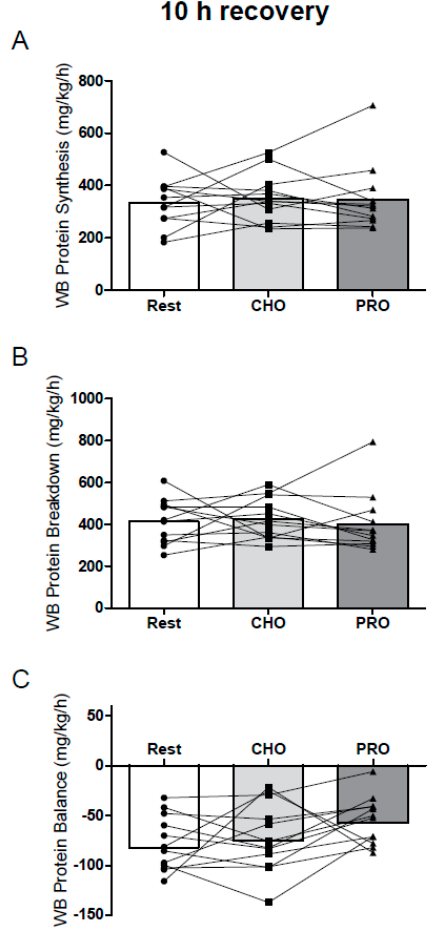
Figure 2. 10 h whole body (WB) protein synthesis ( A ), protein breakdown ( B ), and protein balance ( C ), at rest (Rest) and after whole body resistance exercise supplemented with 25 g whey protein (PRO) and isocaloric carbohydrate (CHO), calculated using urinary [ 15 N]ammonia end product enrichment. P = 0.064 for one-way (condition) repeated-measures ANOVA of whole body protein balance. Values are individual means; n = 12. WB, whole body.